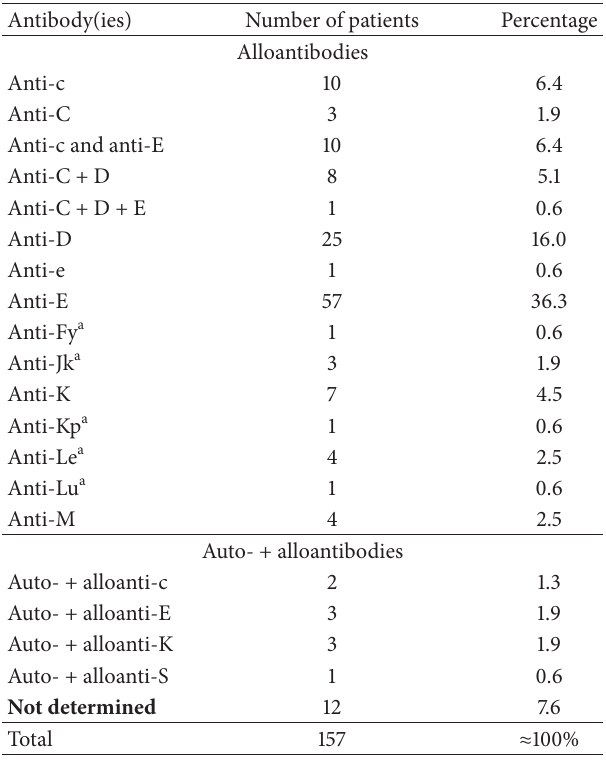
Table 3: Specificities of